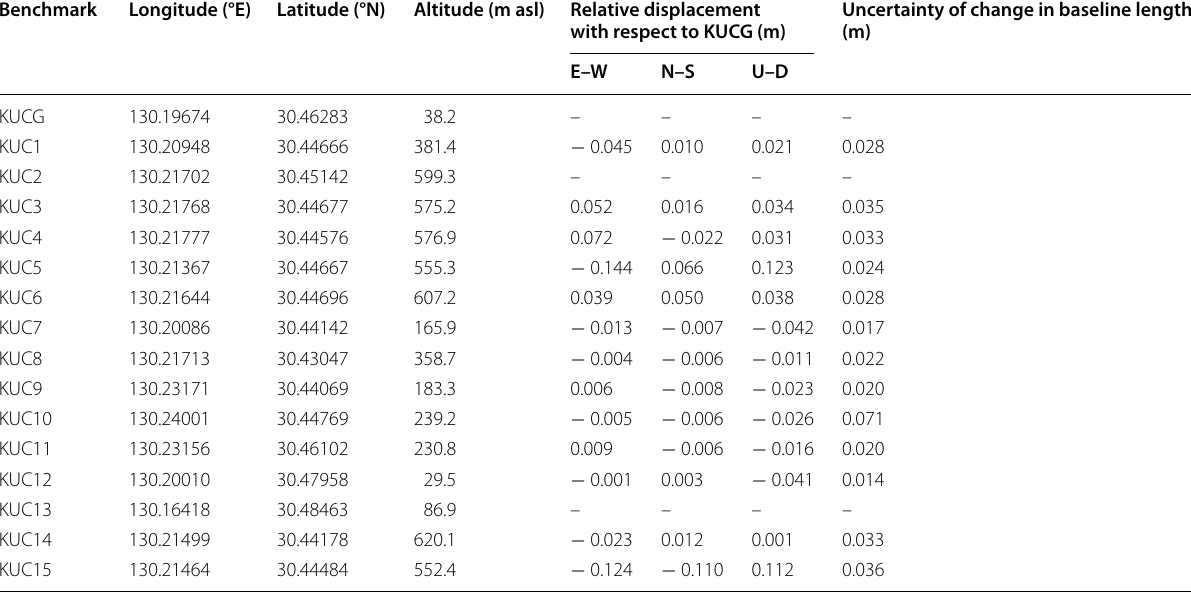
Table 1 Coordinates of GPS benchmarks at Kuchinoerabu-jima, relative displacements with respect to KUCG during Jan- uary 2006–April 2014, and uncertainty of change in baseline